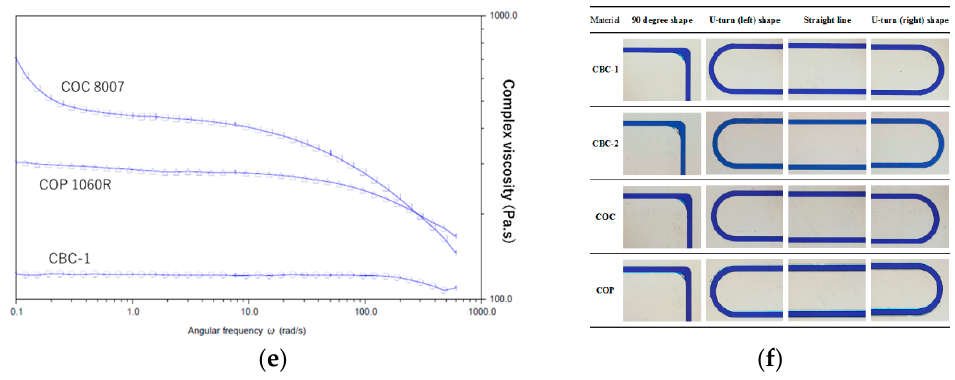
Figure 3. Thermoplastic bonding strength (blue line) and thermoplastic substrate thickness after bonding (red line) for various bonding temperatures for ( a ) CBC-1, ( b ) CBC-2, ( c ) COC, and ( d ) COP. ( e ) Complex viscosity measurement for CBC-1, COC, and COP. The bonding strength and substrate thickness values are averaged on the basis of three individual measurements; ( f ) Microchannels injected with a blue food dye (15 µL/min). No microchannel collapse can be observed under optimal bonding conditions. The bonding strength drop at 117 °C for CBC-1 was because the polymer stuck to the glass during the release of bonded pairs. The operating conditions when the complex viscosity was measured were 250 °C, strain: 5% in N 2 gas.